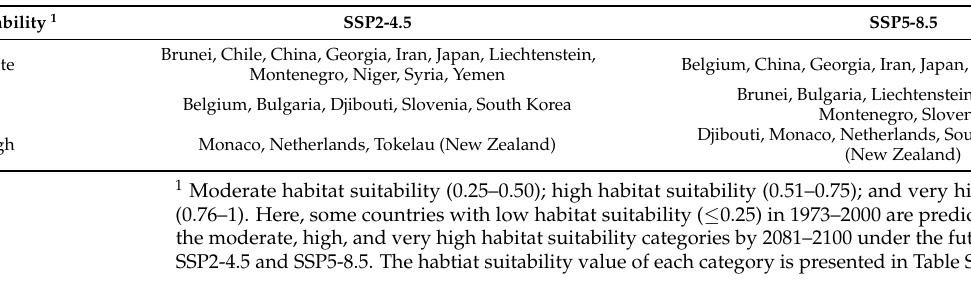
Table 4. Predicted habitat suitability for P . hysterophorus in different nations in 2081–2100 under future climate scenarios (SSP2-4.5 and SSP5-8.5).